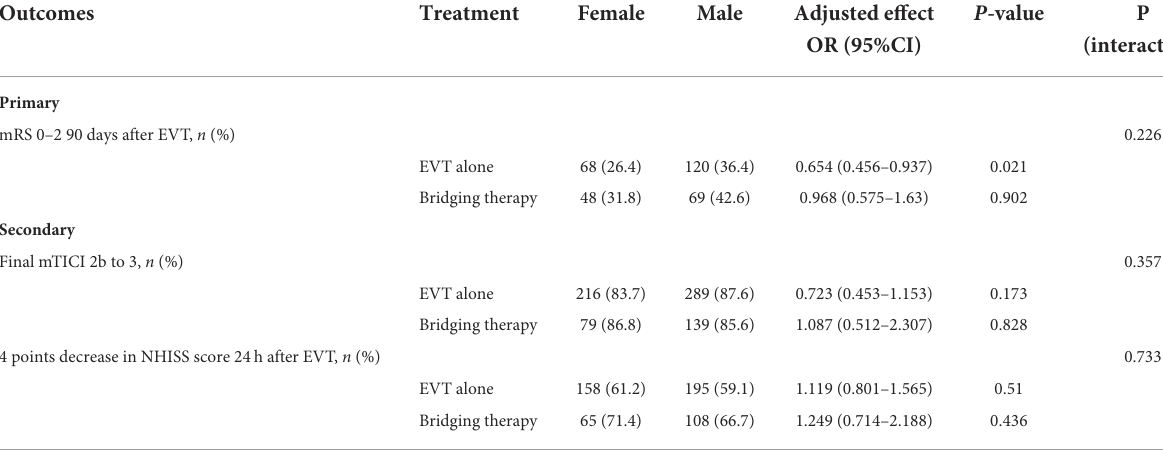
TABLE 2 Sex differences in primary and secondary outcomes after being